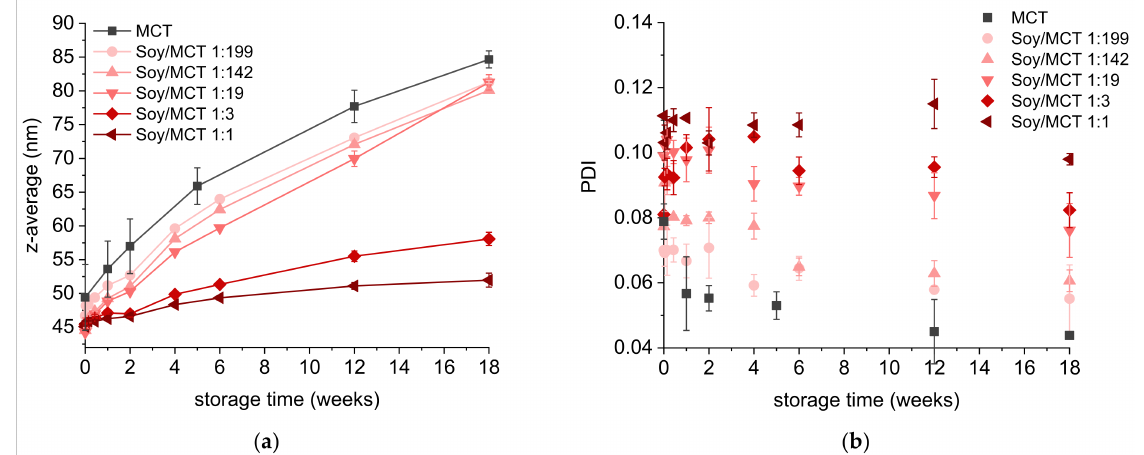
Figure 6. ( a ) Z-average diameter and ( b ) PDI of nanoemulsions with various mass ratios of soybean oil/MCT or just MCT and 5% SL as emulsifier as a function of storage time. Nanoemulsions were produced by PME with Anodisc ™ 20 nm membranes (0.2 mL/s). Mean of 3 independent experiments ( n = 3) ± standard deviation.